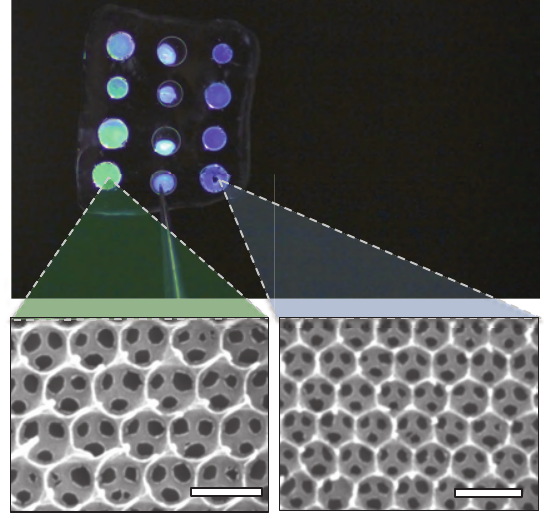
Fig. 4. DNA-based self-assembly of chiral plasmonic nanoparticles. Reprinted by permission from [114], Copyright 2012, Macmillan Publishers